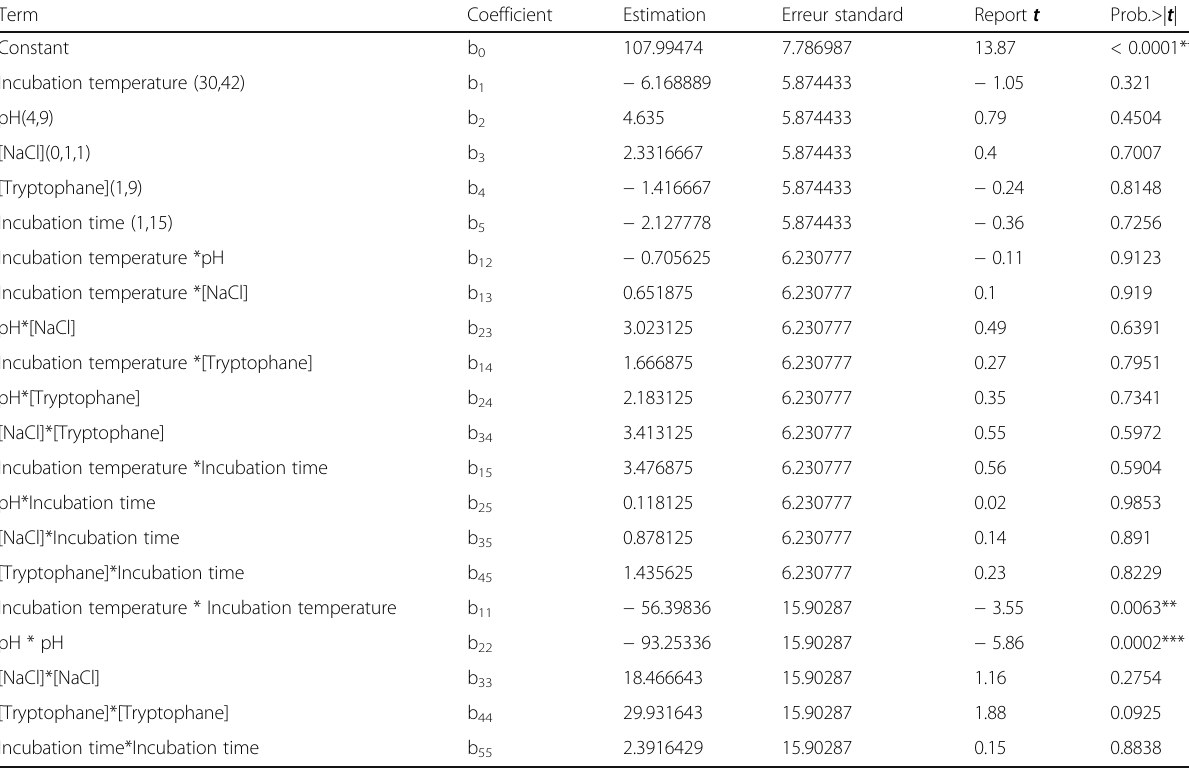
Table 4 Effects of model coefficients that relate the response to factors